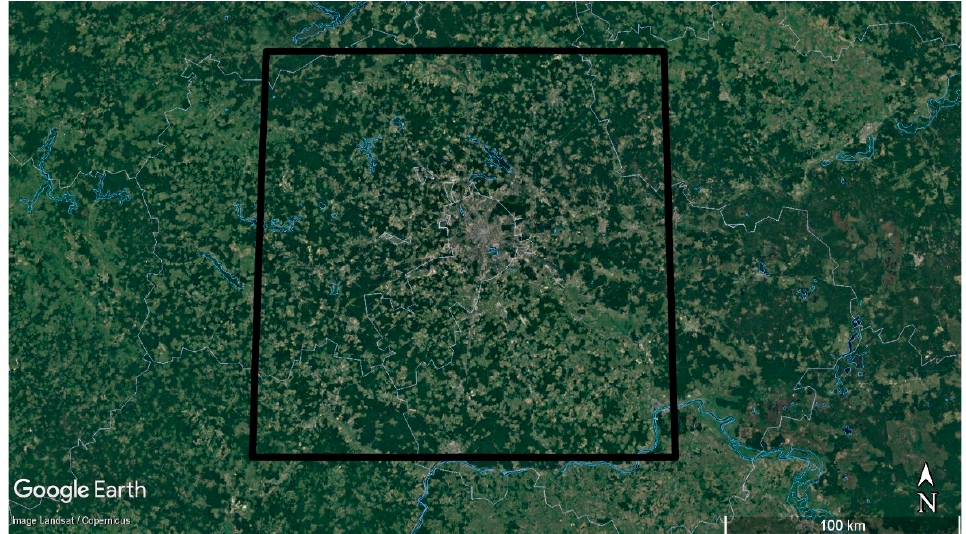
Figure 3. The area of numerical experiments. The borders of Russian regions are shown in white. The Moscow metropolis is located in the center. The figure was created using Google Earth Pro.